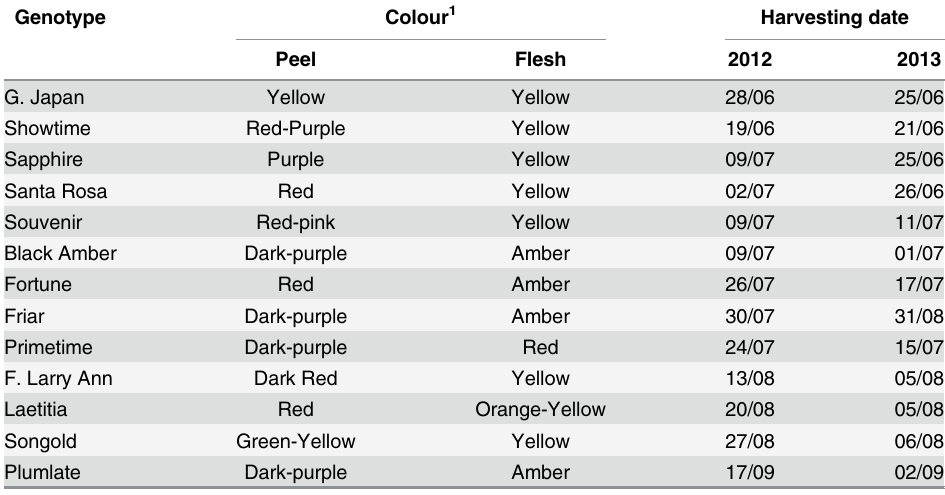
Table 1. Harvesting date and colours of peel and flesh of plum cultivars